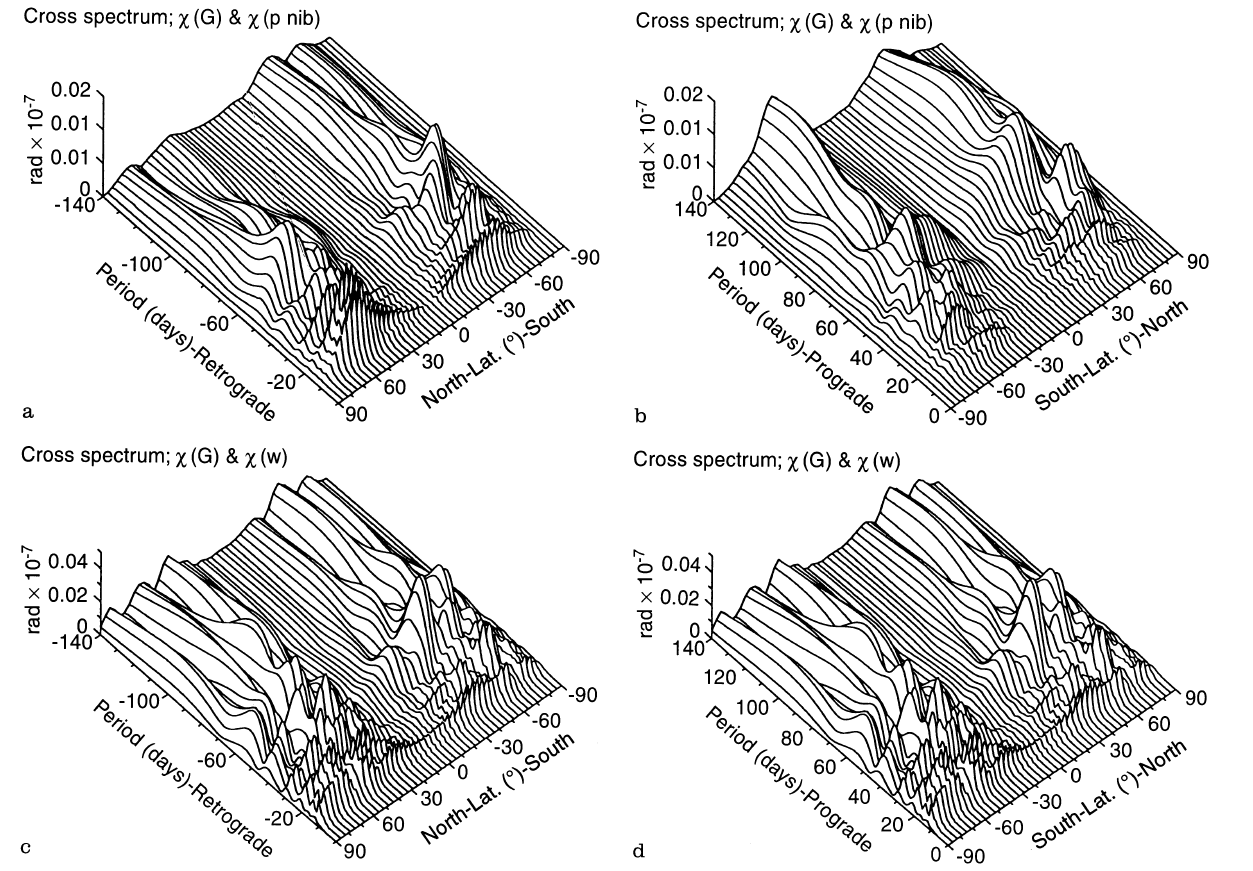
of a year, in 96 latitude belts. The a, b pressure, and c, d wind terms have been taken into account in the zonal EAAM (JMA) excitation